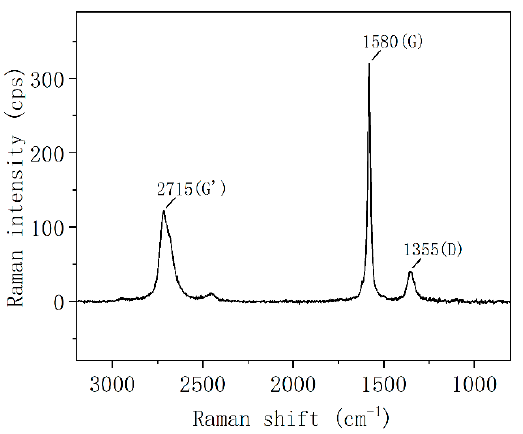
Figure 5. The Raman spectra of mechanically exfoliated MEG samples.